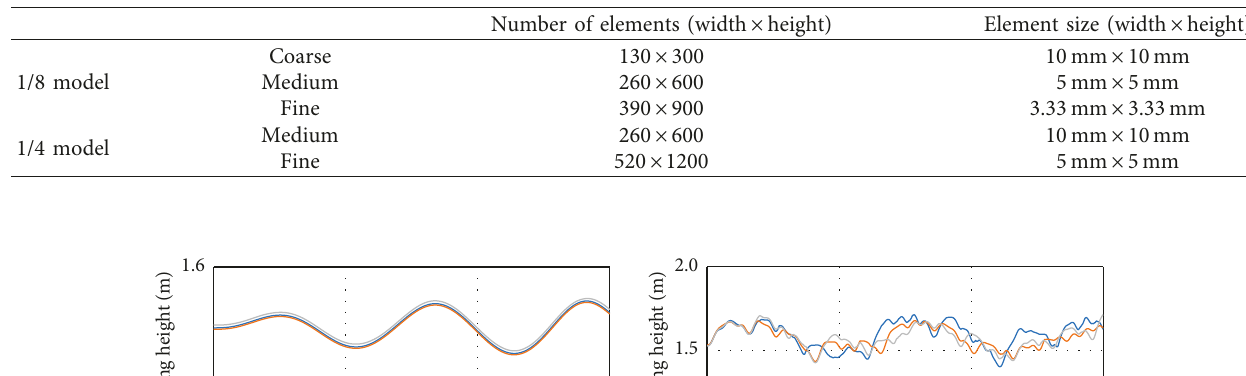
Table 2: Developed CFD models for mesh sensitivity study.